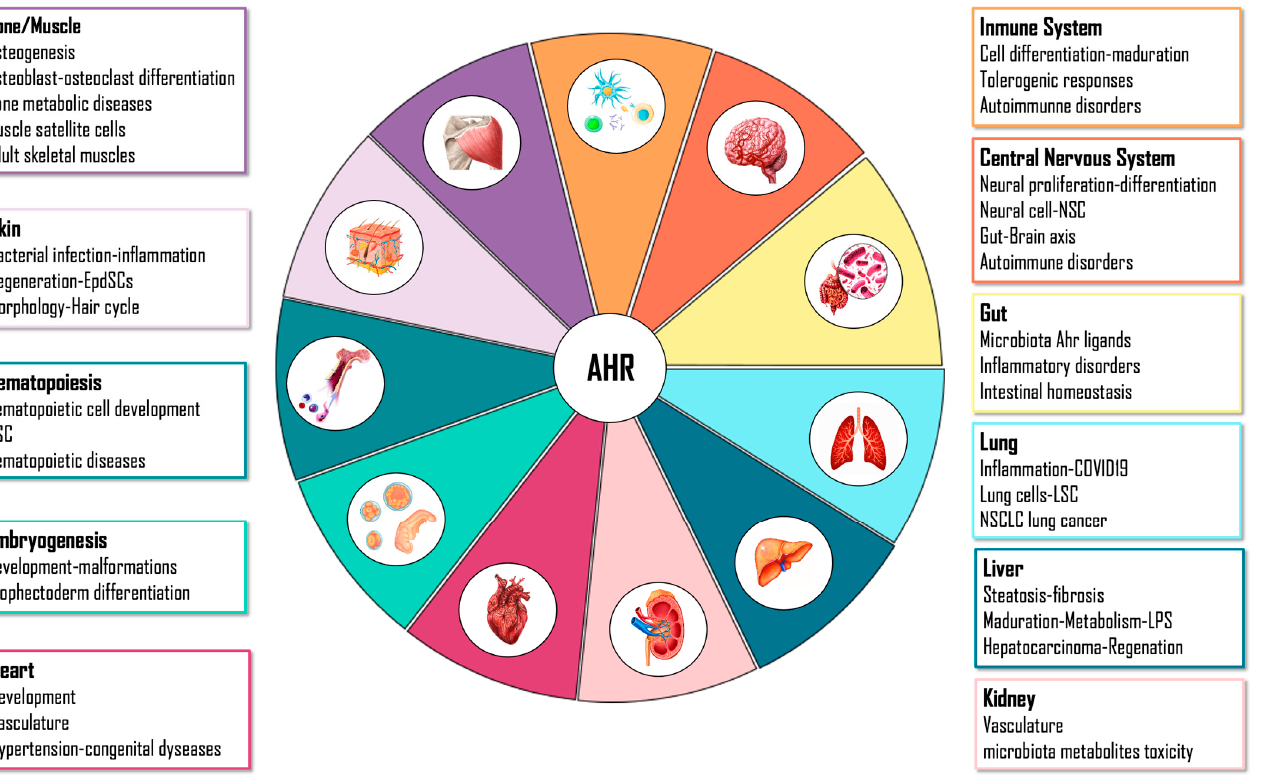
Figure 2. Implication of AHR in organ homeostasis regulation.